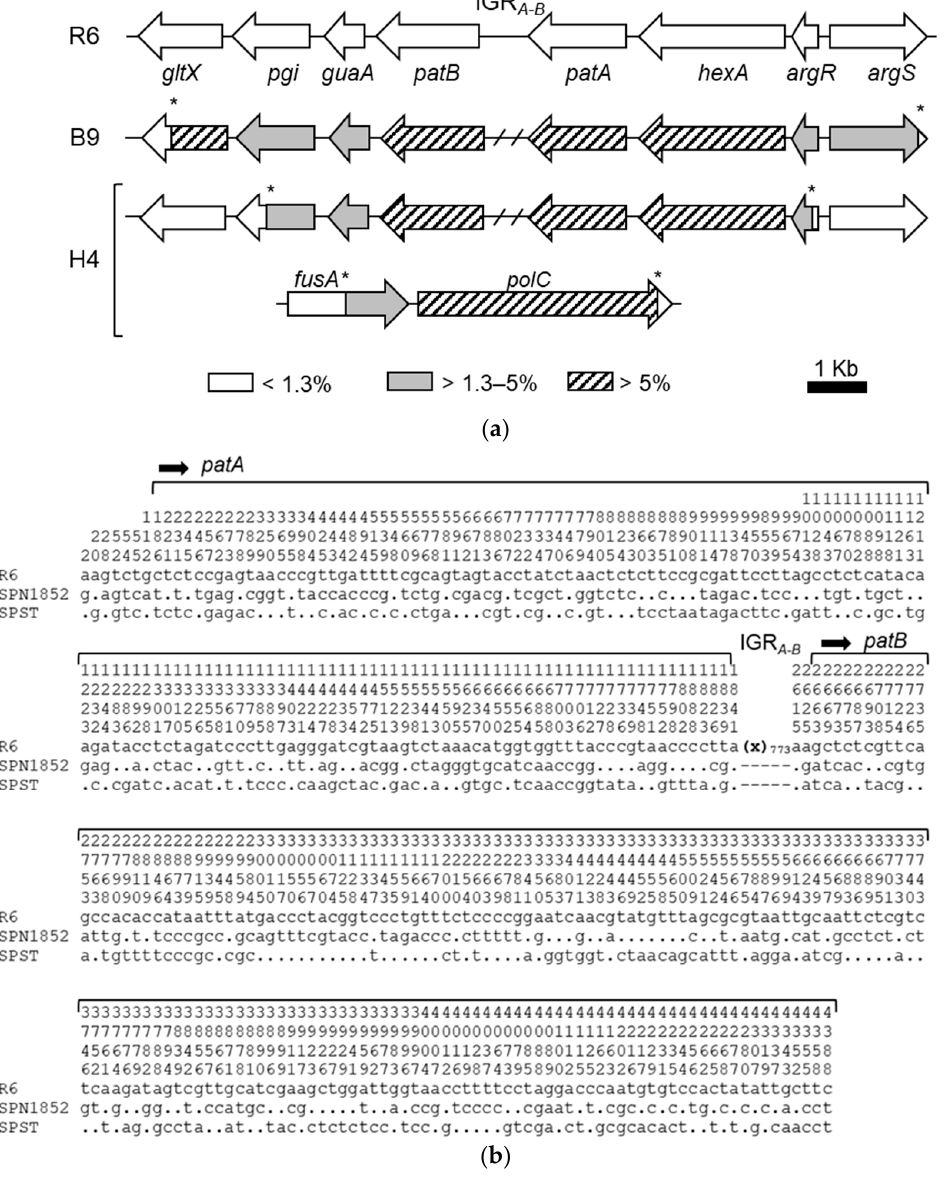
Figure 2. Genomic map of recombination regions and patAB sequence comparison. ( a ) Schematic representation of the regions in B9 and H4 compared to R6. Nucleotide divergence with respect to R6 in the genes (arrows) is indicated. Asterisks denote the recombination points on each transformant. The patA - patB intergenic region (IGR A-B ) is labelled in R6 and its absence in SPN1852 and SPS type strain (SPST) is illustrated by a crosshatched line. ( b ) Comparison of patAB operon nucleotide sequence between R6, SPN1852, and SPST (NCBI reference sequence: NC_015875.1). Sequence starts at the first nucleotide after the stop codon of the upstream hexA gene. Nucleotide positions are indicated vertically above the sequence. Only differences with respect to R6 are shown. Nucleotides identical to R6 are illustrated by a dot and absent sites are represented by a dash. Sequences of H4 and B9 were identical to that of SPN1852. IGR between patA and patB (IGR A-B ) is represented by (x) followed by the number of nucleotides not included in the